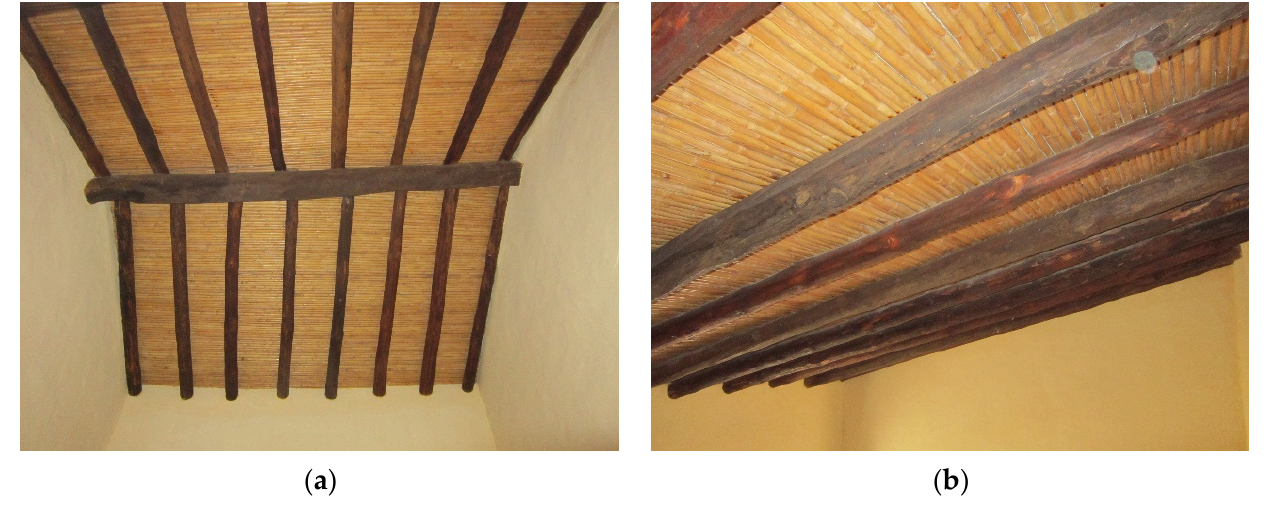
Figure 1. ( a , b ) Use of reed for roof construction in Alentejo region (Portugal). The insulation of the walls was also improved by using reed in the vernacular build- ings. In the centre of Portugal, some of the “palheiros” (palafitic timber buildings) used reed inside the exterior walls [12]. Reed was also used in the frames of “tabique” walls (wood-framed walls finished with clay mortar), a technique that can be found almost everywhere in Portugal [16]. These examples of the use of the reed emphasise its important role in Portuguese vernacular architecture and its importance as an insulation material in this type of